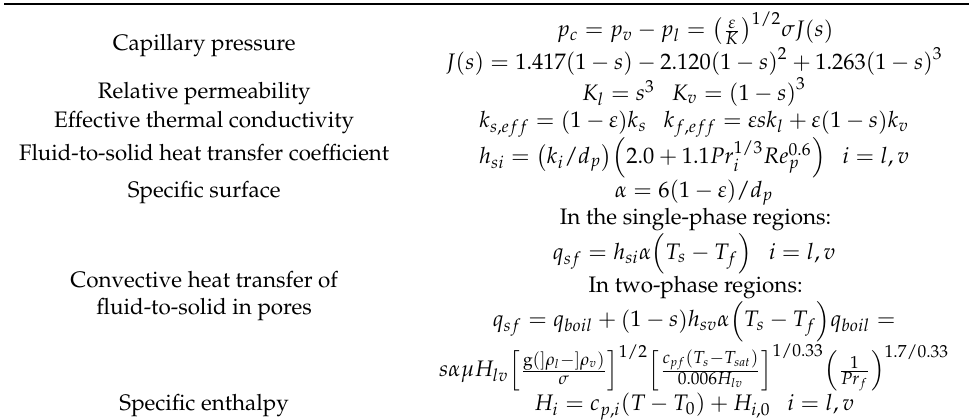
Table 1. Constitutive